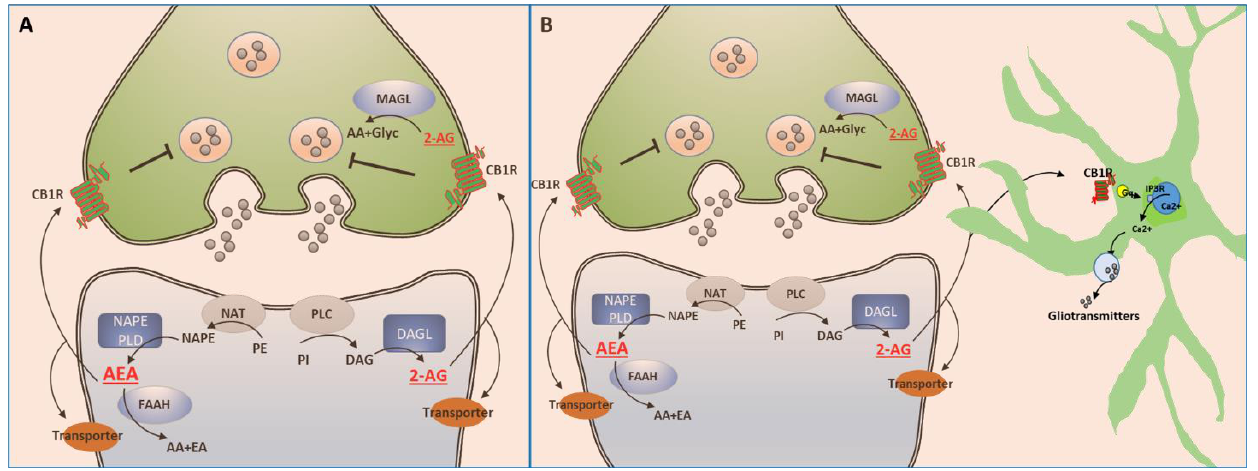
Figure 1. Schematic representation of the endocannabinoid signaling system. Endocannabinoids (eCBs) 2AG (2-arachidonoylglycerol) and AEA (anandamide) are synthesized in postsynaptic neu- rons and act pre-synaptically at their receptors (CB1Rs) in a retrograde mode ( A ). eCBs can also activate CB1R localized post-synaptically in some cases. In general, activation of CB1 receptors by eCBs decreases the probability of neurotransmitter release through multiple mechanisms, compris- ing inhibition of calcium influx and activation of potassium channels These effects are terminated by eCB reuptake followed by degradation: 2AG by MAGL pre-synaptically and AEA by FAAH post-synaptically. A large proportion (45 – 48%) of synapses in different brain regions is tripartite ( B ), formed by pre-synaptic and post-synaptic neurons, and a glial cell — an astrocyte — which ex- presses CB1R. In response to neuronal activation, eCBs released by the postsynaptic neurons can activate CB1R expressed on astrocytes. The astrocytes respond with an increase in intracellular cal- cium leading to release of gliotransmitters ( B ). 6. Signaling of the ECS The mode of action of the eCBs on their receptors (Figure 1) reveals that eCBs syn- thesized in postsynaptic neurons act pre-synaptically at CB1Rs in a retrograde mode [46]. There are data showing that eCBs can also activate localized CB1Rs post-synaptically [47,48]. In general, activation of CB1 receptors by eCBs decreases the probability of release of neurotransmitters through multiple mechanisms, comprising an inhibition of calcium influx and an activation of potassium channels [46 – 49]. These effects are terminated by eCB reuptake followed by degradation; 2AG by MAGL pre-synaptically and AEA by FAAH post-synaptically, as mentioned above. Furthermore, a large proportion (45 – 48%) of synapses in different brain regions are tripartite [47] (Figure 1B), formed by a pre-syn- aptic neuron, a post-synaptic neuron, and a glial cell, usually an astrocyte, which ex- presses CB1R [47]. In response to neuronal activation, eCBs are released by the postsyn- aptic neurons and activate CB1R expressed on astrocytes. The astrocytes respond with an increase in calcium from intracellular stores leading to the release of gliotransmitters (Fig- ure 1B), capable of modulating the presynaptic and postsynaptic circuit elements [47,50,51]. Through these mechanisms eCBs can inhibit pre-synaptic neurotransmitter re- lease at both GABA and glutamate terminals, thus modulating several neurotransmitter systems [5,47,52]. As illustrated for dopamine neurons, CB1 receptors expressed at pre- synaptic glutamatergic and GABAergic inputs to DA neurons may facilitate or suppress dopaminergic neuronal activity by modifying such inputs [53 – 55]. CB1 receptors on GA- BAergic terminals (Figure 2A) can facilitate dopaminergic activity through suppression of the inhibitory input onto GABA receptors present on DA neurons [56 – 59], leading to an increase of DA release in areas such as the nucleus accumbens (NAc) of the ventral stria- tum.